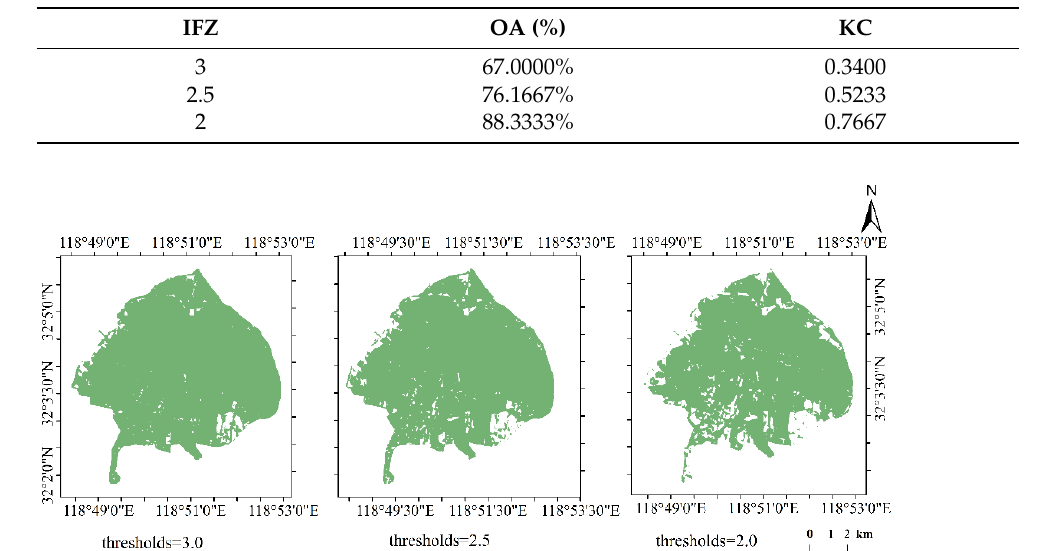
Table 4. Accuracy evaluation results for different thresholds.